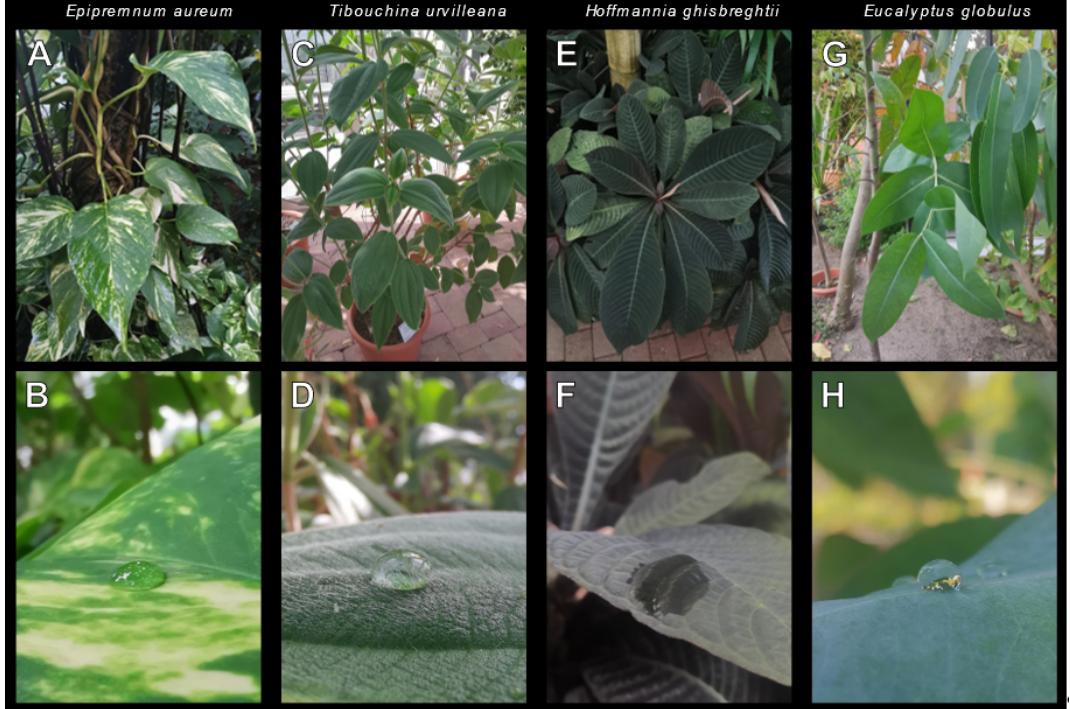
Figure 2. Plant habitus and a closeup of adaxial leaf surface with a waterdrop . ( A , B ) Epipremnum aureum. ( C , D ) Tibouchina urvilleana ( E , F ) Hoffmannia ghiesbreghtii . ( G , H ) Eucalyptus globulus . The contact angle of the droplet indicates the hydrophilicity/hydrophobicity of the leaf surface.